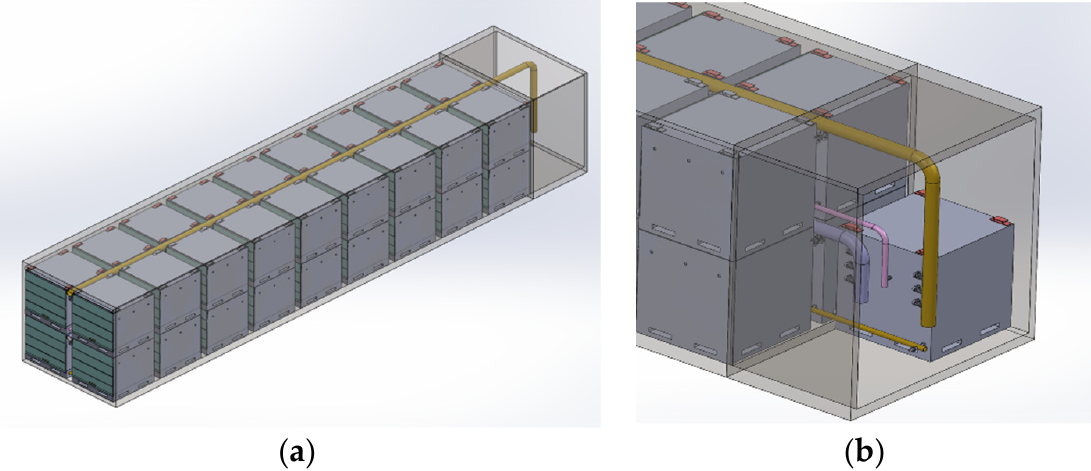
Figure 3. Conceptual design of the mini containers’ assembly in a conventional truck: ( a ) isometric view; ( b ) central driving unit (CDU).